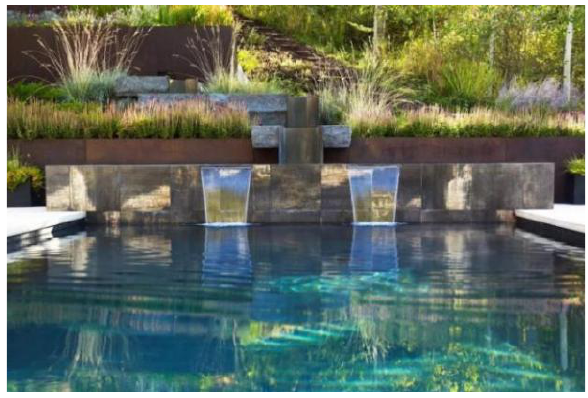
Figure 7. Anaya Water Plank Path.